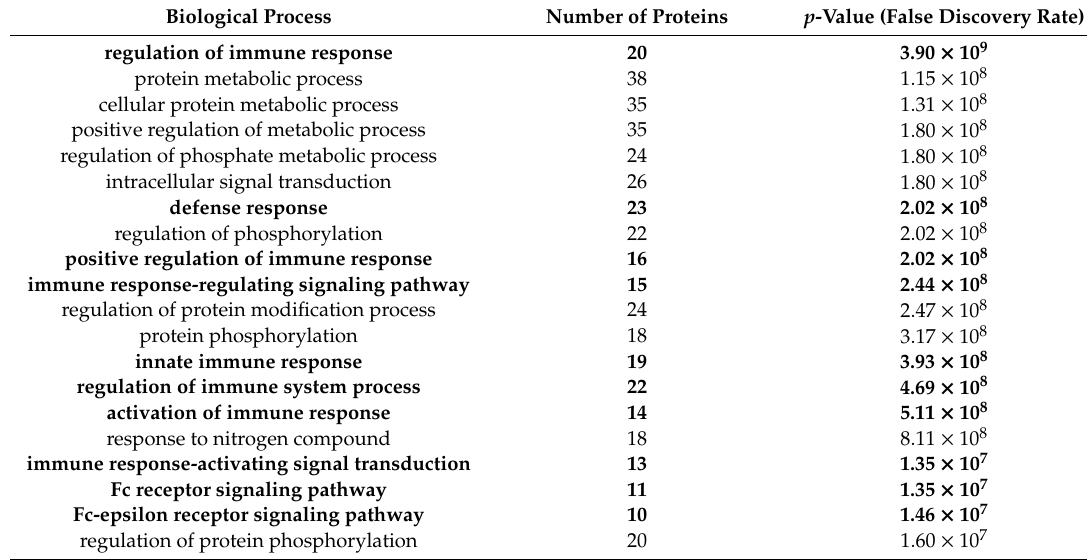
Table 5. Top 20 GO biological processes enriched from unique peptides in the C. perfringens challenge jejunum (compared to postbiotic and postbiotic plus C. perfringens challenge groups).